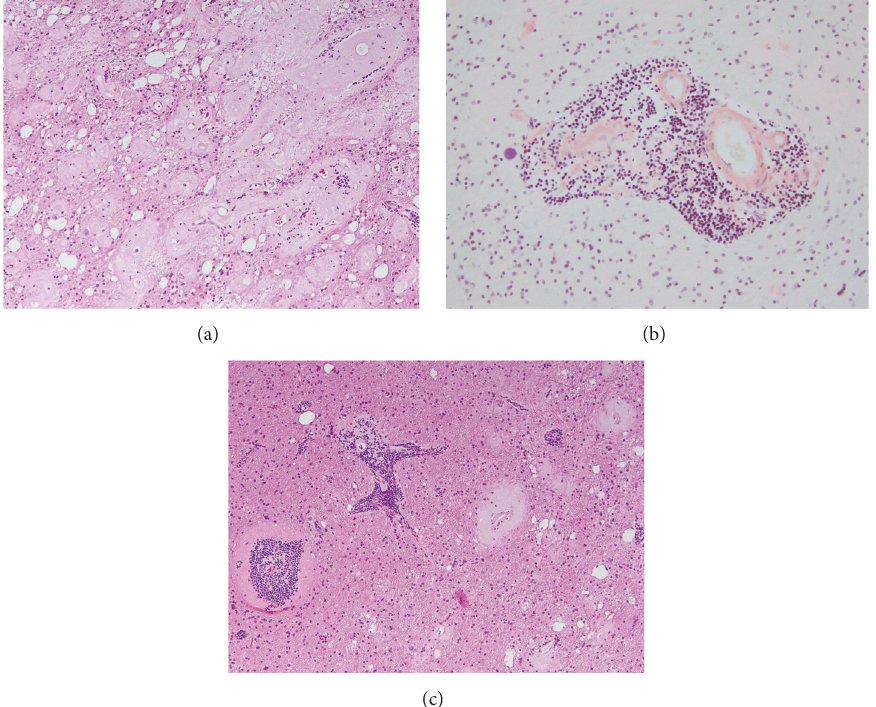
Figure 2: (a) Abundant accumulation of parenchymal, vascular, and perivascular amyloid, hematoxylin and eosin stain, original magnification 100x. (b) Congo-red stain highlights the amyloid deposition in a parenchymal blood vessel that also shows perivascular lymphocytic infiltration, original magnification 200x. (c) Small intraparenchymal blood vessels with perivascular lymphoplasmacytic infiltrate, hematoxylin and eosin stain, original magnification